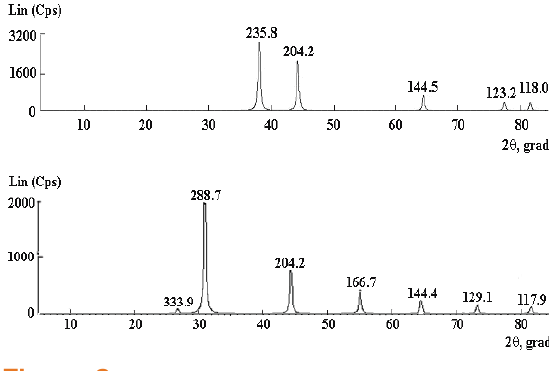
Figure 6. Theoretical XRD-patterns of elemental silver contained in initial Ag- GIM (a) and of elemental silver formed in GIM as a result of “re-precipitation” process